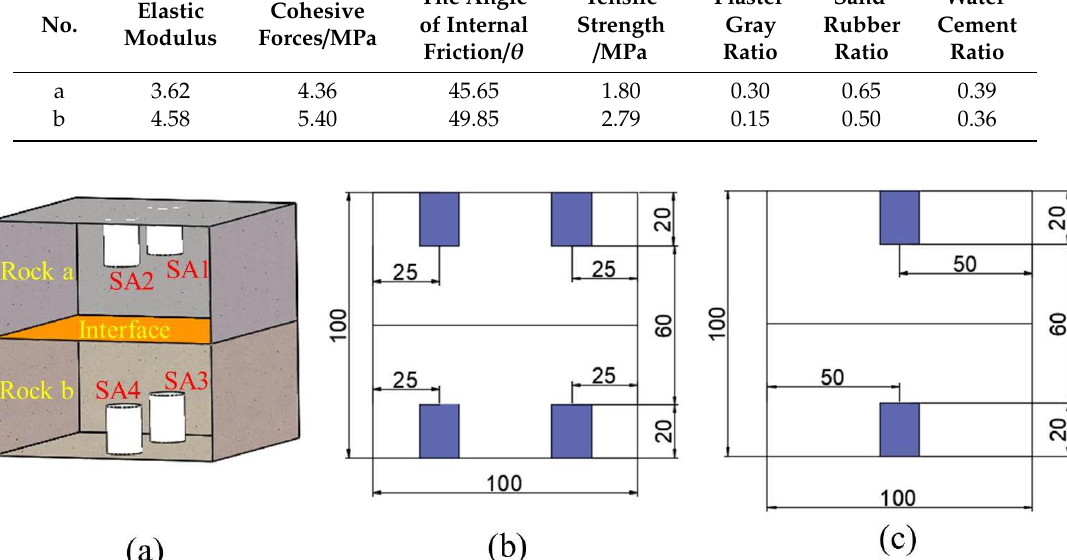
Table 1. Material ratio and mechanical parameters.